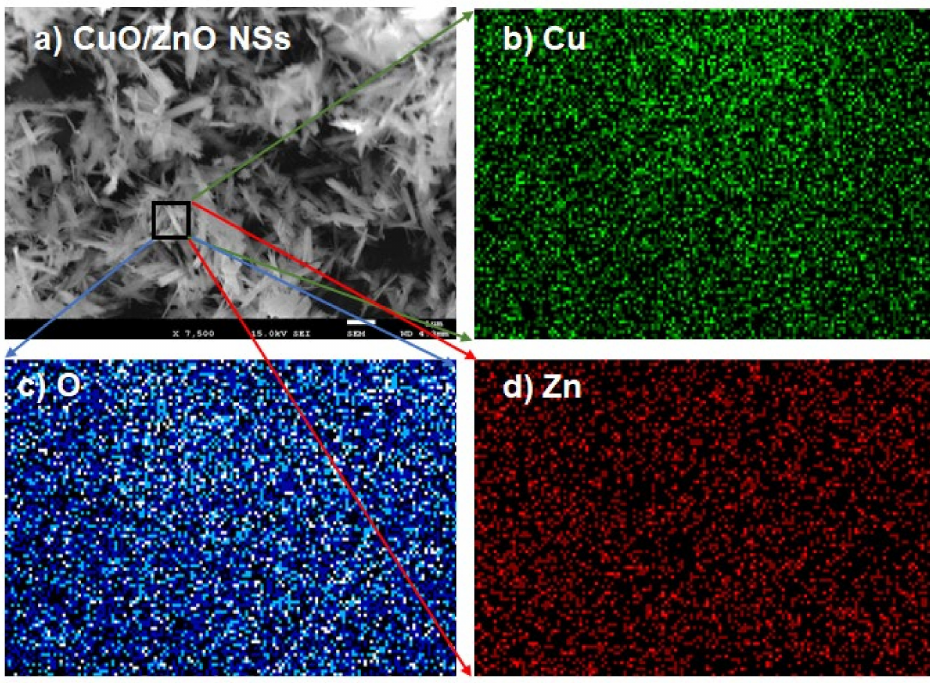
Figure 2. Elemental mapping of CuO/ZnO nanospike materials. ( a ) SEM image of NSs. ( b ) Elemental mapping of the copper element. ( c ) Elemental mapping of the oxygen element. ( d ) Elemental mapping of the zinc element.